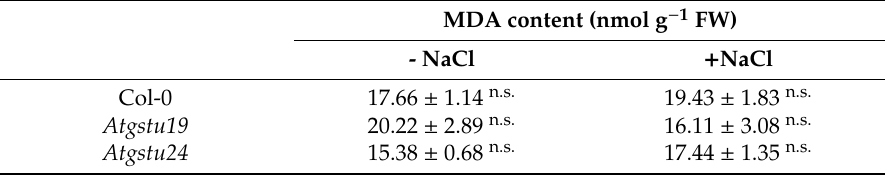
Figure 3. Cell vitality and level of reactive oxygen species (ROS) in cotyledons and root tips of two-week-old wild-type (Col-0) and GSTU mutant ( Atgstu19 and Atgstu24 ) Arabidopsis plants treated with 150 mM NaCl for 48 h. ( A ) Vitality of cotyledons and ( B ) root tips investigated by fluorescein diacetate. ( C ) ROS level in cotyledons detected by 2’-7’-dichlorodihydrofluorescein diacetate. ( D ) ROS level in root tips under the same conditions as described above. Means ± SE, n = 9 denoted by di ff erent letters indicate a significant di ff erence between the treatments at a p < 0.05 level according to Duncan’s test. Table 1. Malondialdehyde (MDA) content of two-week-old wild-type (Col-0) and glutathione transferase ( GSTU ) mutant ( Atgstu19 and Atgstu24 ) Arabidopsis plants treated with 150 mM NaCl for 48